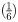
True positive rate as a function of node degree (given 10000 observations) of shrinkage (blue), ridge (orange), and lasso (green) estimated partial correlations, and of pairwise correlations (red).For each network, nodes were divided into 6 bins according to degree: 5 equally-sized bins, and a 6th bin containing the 50 nodes with the highest degree (i.e., the hubs in the hub networks). TPR is shown for each pairing of degree bins (e.g., sixteenth pair (16) refers to edges between the nodes with lowest degrees and the nodes with highest degrees; rightmost pair (66) refers to edges between the nodes with highest degrees).